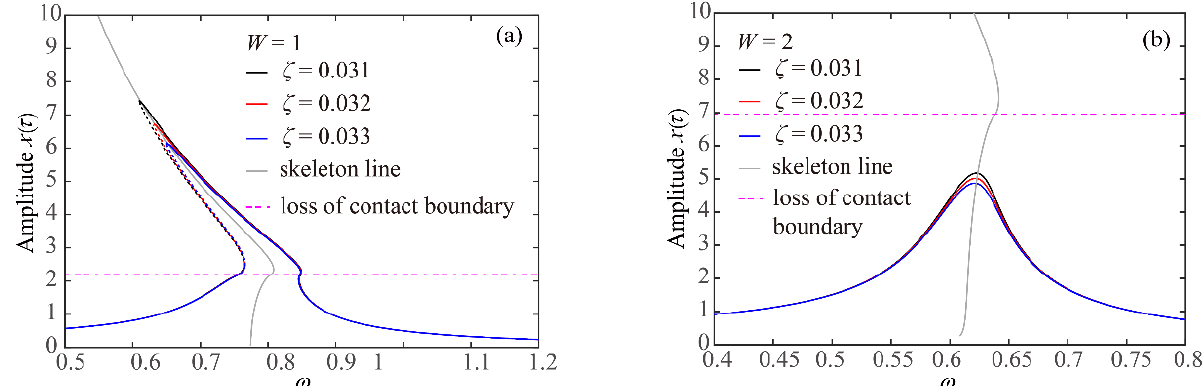
Figure 7. For α = 0.6, influence of ζ on the frequency-response peak-to-peak curves of one-sided contact system, ( a ) W = 1 and ( b ) W = 2.